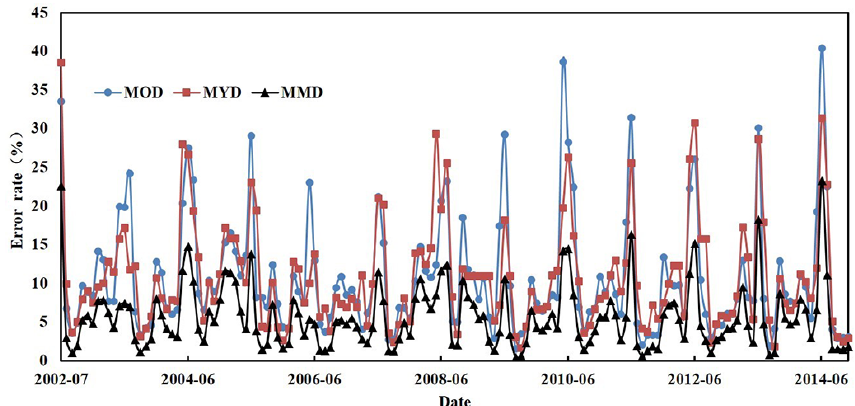
Figure A1. Monthly error rate of MOD, MYD, and MMD.